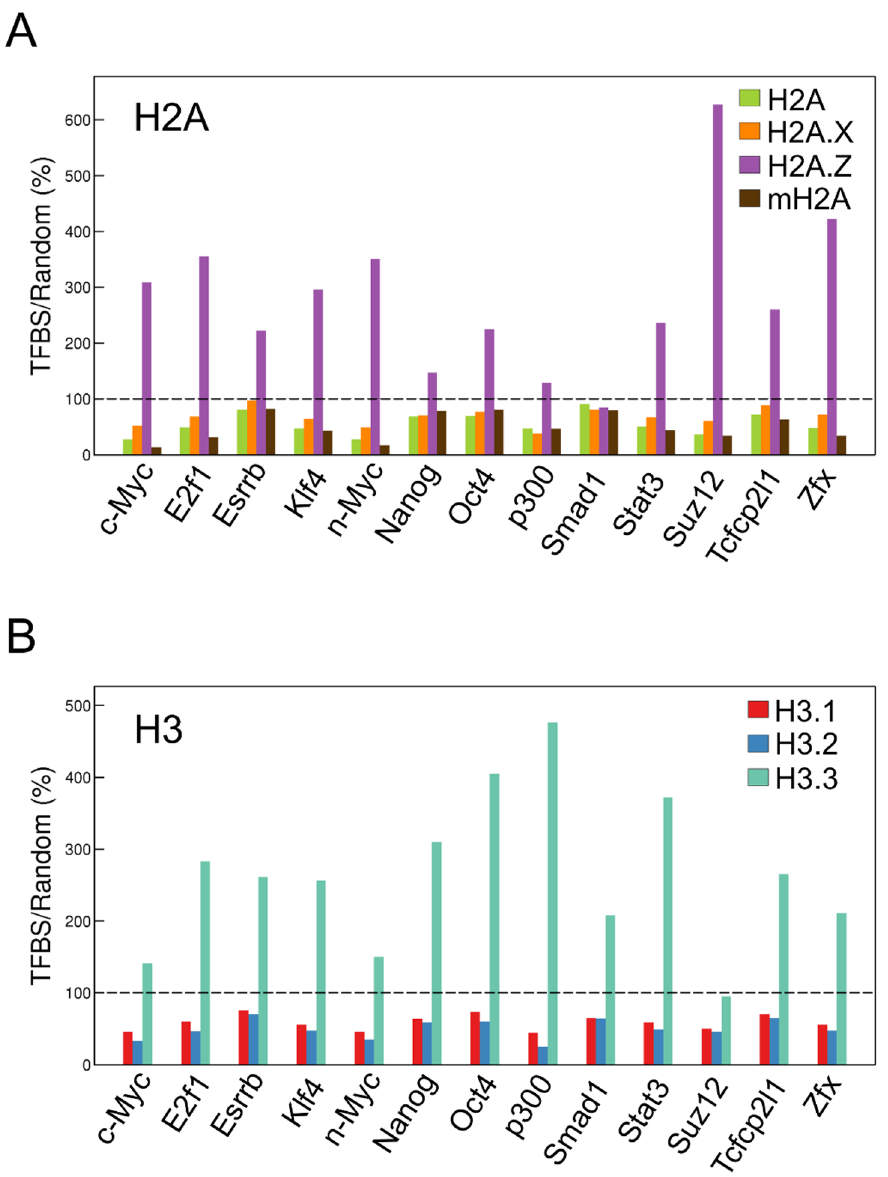
Figure 3. Enrichment of histone variants in enhancer regions. Bars represent the ratios (%) of enrichment of the histone H2A (A) and H3 (B) variants 6 200 bp from the center of the transcription factor binding site (TFBS) as defined using Chen’s TF ChIPseq data [35] to the average enrichment in 5,000 400-bp regions randomly selected from the whole genome, excluding TFBSs. The dotted line indicates 100%, representing the average value of the enrichment in randomly selected